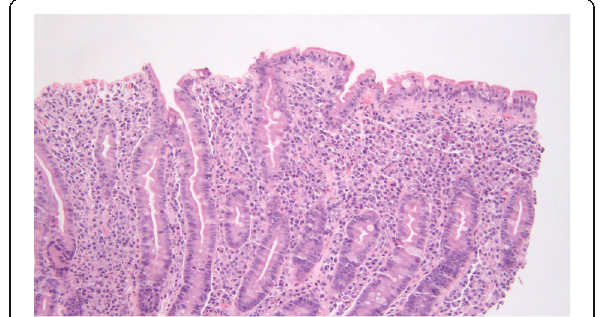
Fig. 3. This flat lesion returned to a state of relative normalcy after 24 months. Such recovery was associated with a reduction of the ABC, though it remained higher than the mean ABC of controls